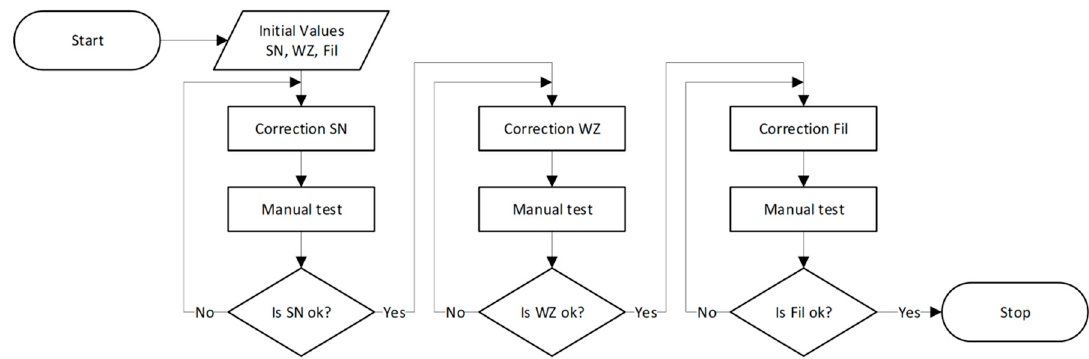
Figure 8. X , Y , Z axes motion path with fourteen different parameter sets T1–T14.